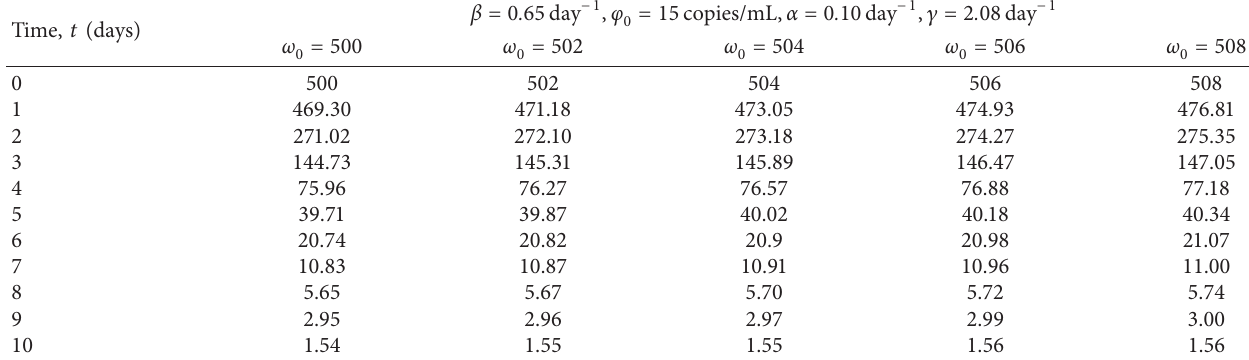
Table 4: The number of infected cells ω for different values of time t and number of potentially infected cells at the beginning of therapy ω Time, t (days)